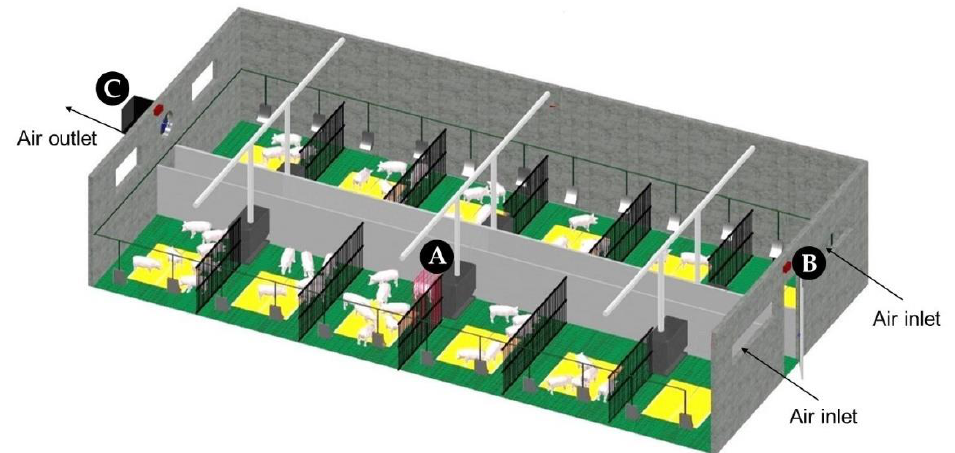
Figure 1. View of the room in which measurements were taken and location of sensors for measure- ments of: (A) carbon dioxide concentration (CO 2 ), ammonia concentration (NH 3 ), relative humidity (RH), temperature (T) and air velocity (V IN ) in the animal zone; (B) temperature in the external corridor (T CA ) and (C) velocity of the air extracted through the ventilation system (V EX ).